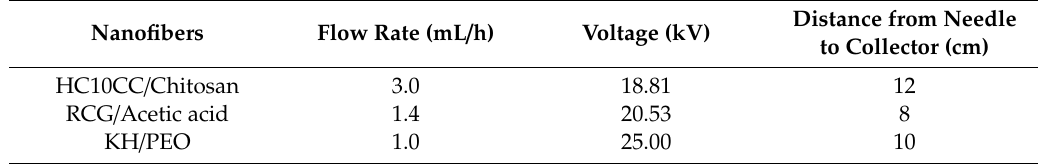
Table 1. Optimal parameters for obtaining of electrospun HC10CC-, RCG-, and KH-based